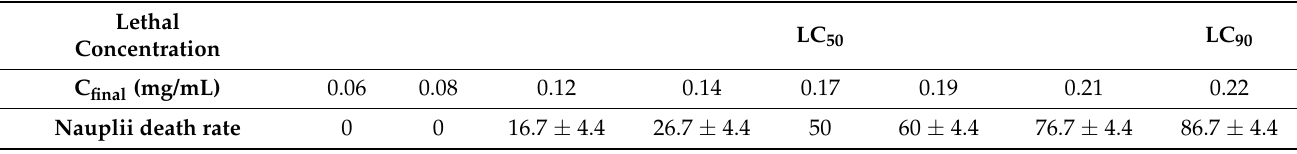
Table 10. Ecotoxicity test with LABSA at pH